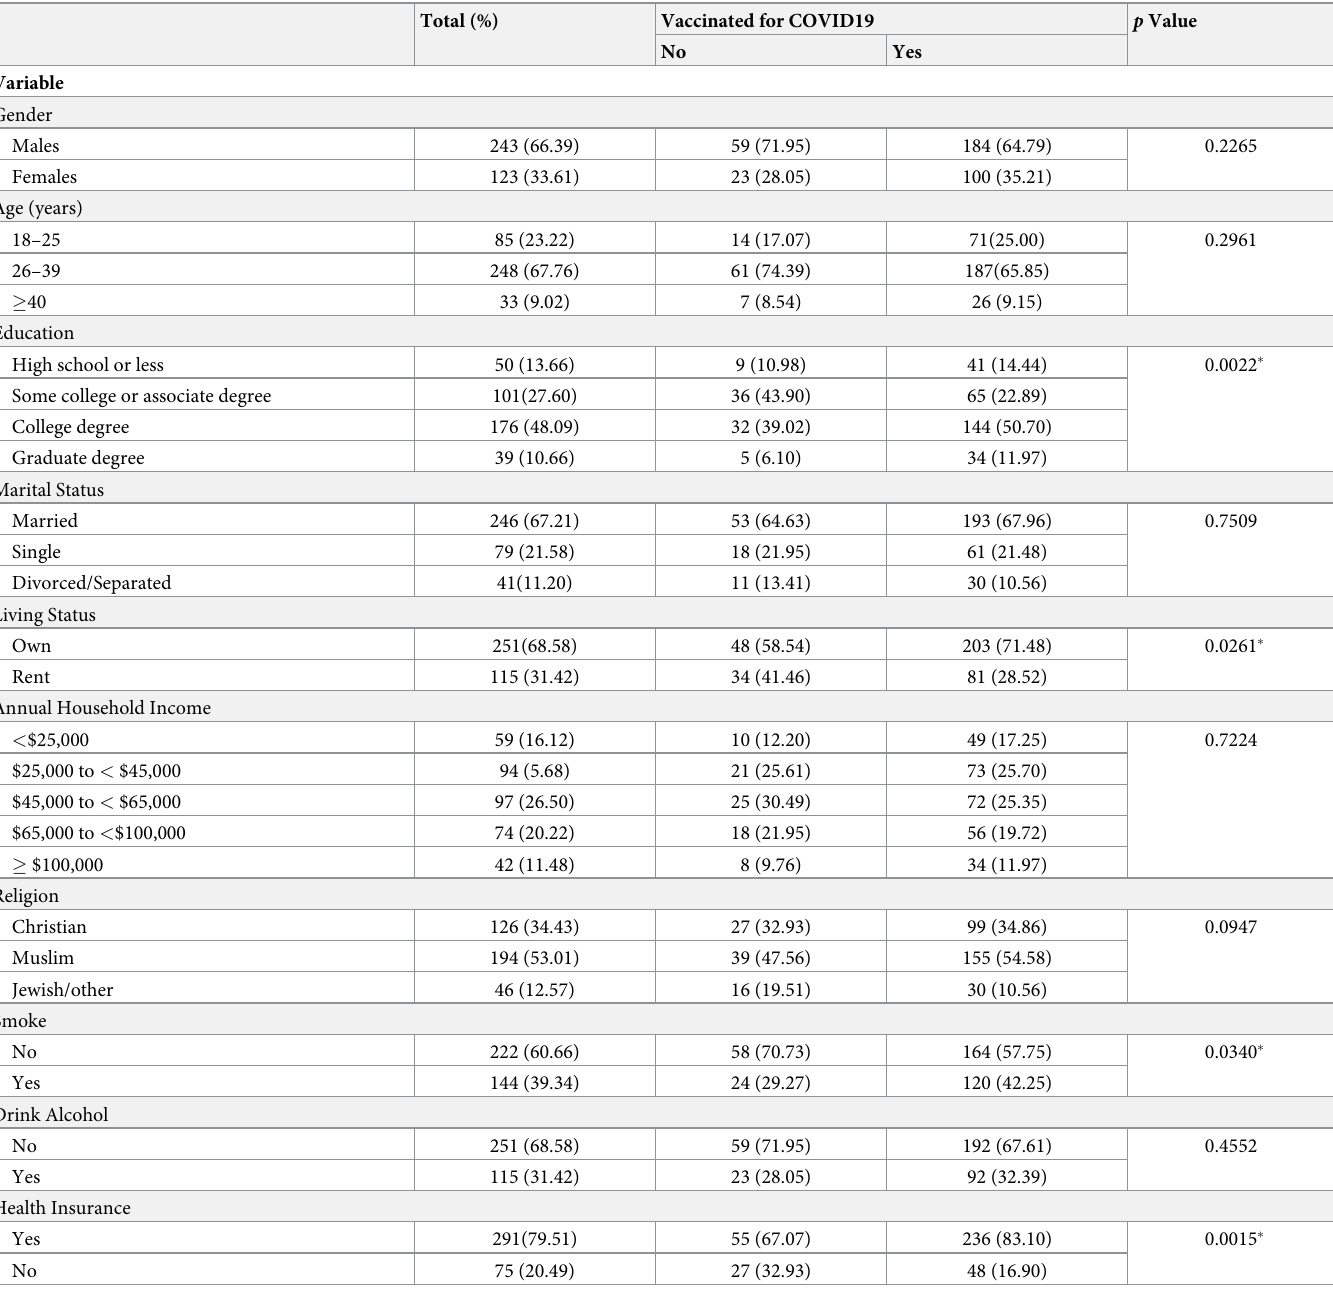
Table 1. Baseline demographic characteristics and COVID-19